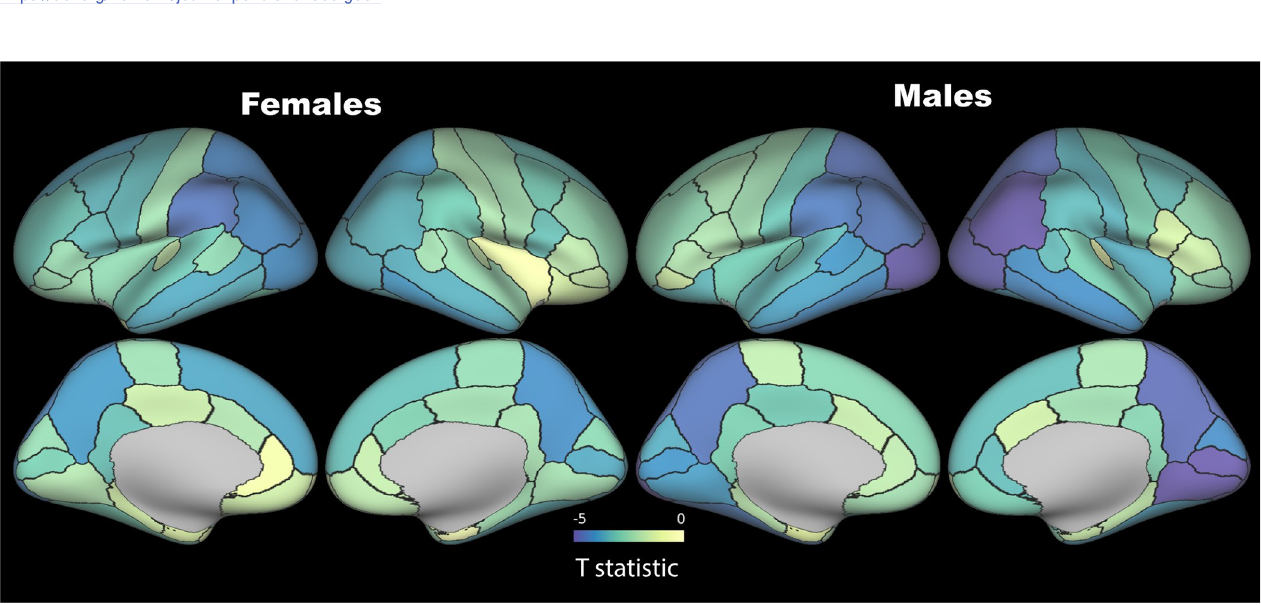
Fig 2. Associations between grey-white matter contrast (on T1w) and leucocyte telomere length. T statistics are shown projected onto the cortical surface as per the colour bar. False Discovery Rate threshold (3921 tests, T = 2.64), Bonferroni threshold (3921 tests, T = 4.21). Parcellations are based on the Desikan- Killiany atlas. Models adjusted for full set of imaging-related confounders, age, age 2 , age 3 , sex, age � sex, leucocyte count, smoking, alcohol intake, body mass index, genetic ancestry.